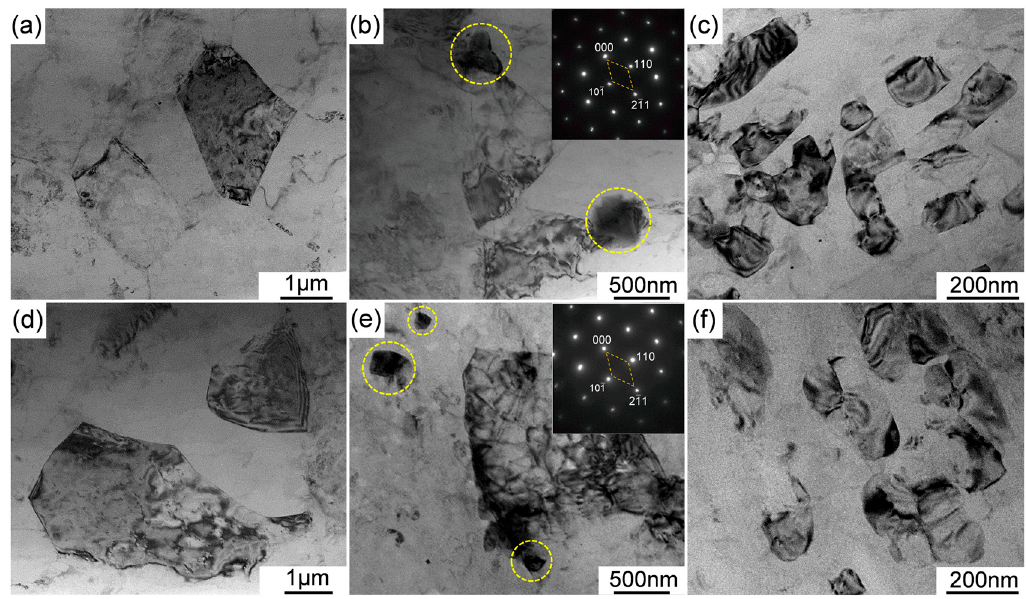
Figure 8. BF-TEM images to showing the recrystallized (DRXed) grains in as-extruded alloys: ( a – c ) Mg-11Li-4Y-2Er-2Zn and ( d – f ) Mg-11Li-8Y-4Er-4Zn.